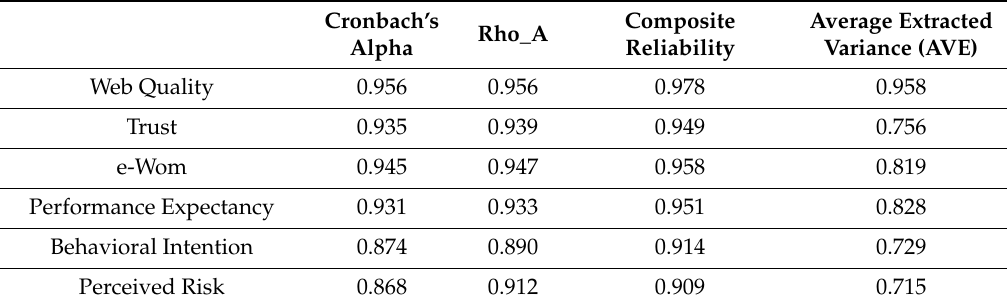
Table 3. Composite reliability and convergent